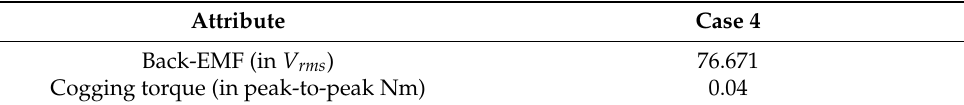
Table 4. No-load